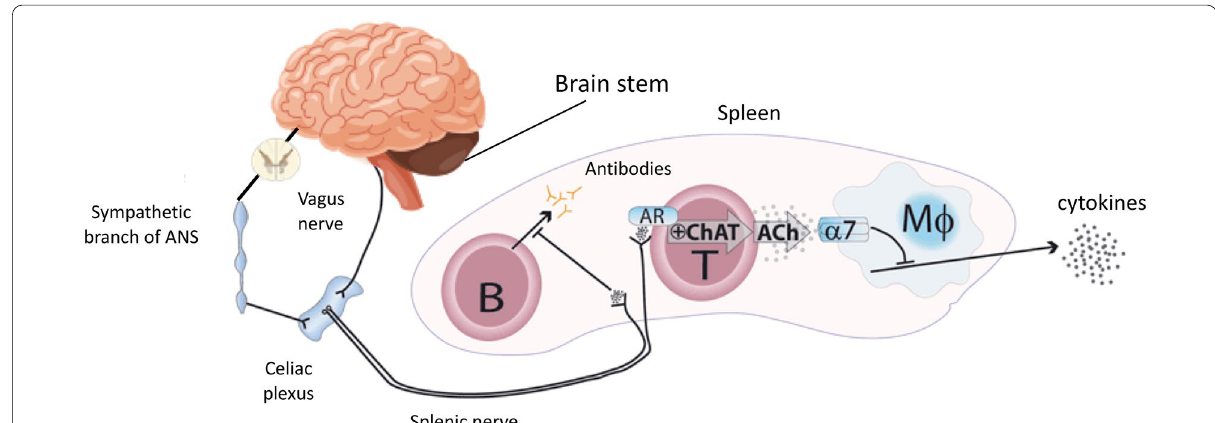
Fig. 3 Illustration of the inflammatory reflex (here, in the spleen). Efferent signals from the brain stem travel through the efferent vagus nerve to the celiac plexus, which also receives input from the sympathetic branch. The catecholaminergic splenic nerve arises in this celiac plexus and projects inside the spleen, where its terminal fibers reach T and B lymphocytes. Efferent signals in the vagus nerve activate the splenic nerve, which releases norepinephrine in the spleen, activating the choline acetyltransferase ‐ expressing T-lymphocytes (ChAT) through their adrenergic receptors (AR). ChAT then release acetylcholine (ACh), which acts on α7 subunits (α7) of the nicotinic acetylcholine receptor on macrophages ( M Φ ), suppressing further release of tumor necrosis factors (TNF). Activation of the splenic nerve also stops B ‐ lymphocyte migration and inhibits their antibody production. Adapted from